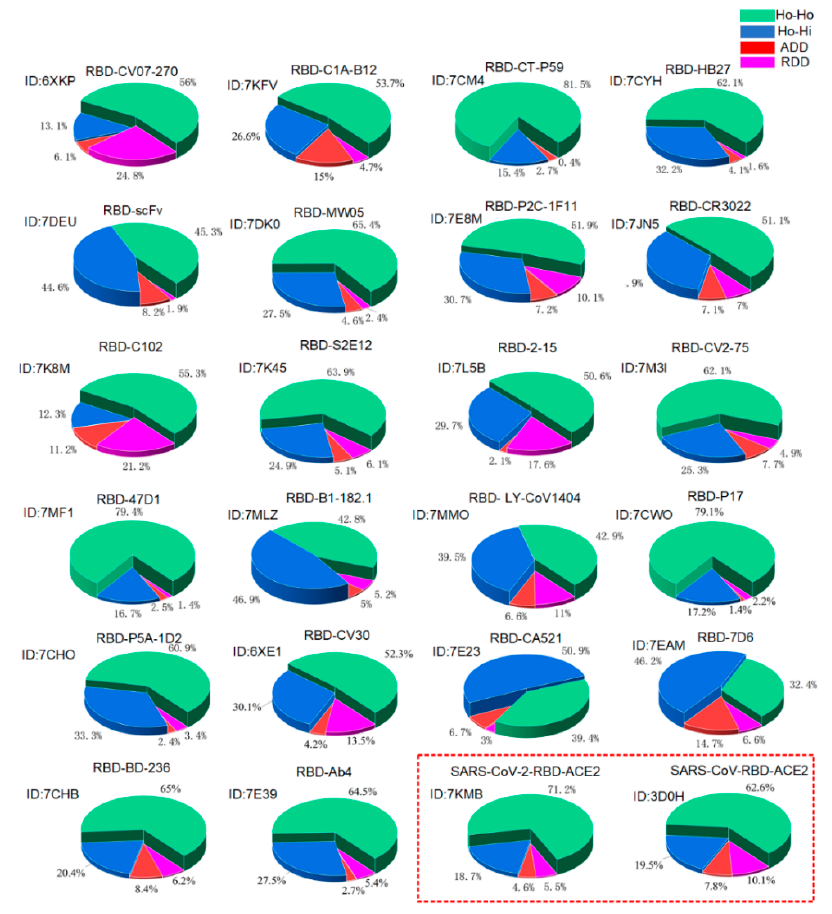
Figure 4. The calculated proportions of SHo-Ho, SHo-Hi, SADD, and SRDD at the interface of RBD–antibody complexes, the RBD–ACE2 complex, and the SARS-CoV-S-RBD–ACE2 complex. The PDBIDs are added in the figure. The results of RBD–ACE2 complex, and the SARS-CoV-S-RBD–ACE2 complex are highlighted with a red dash line.